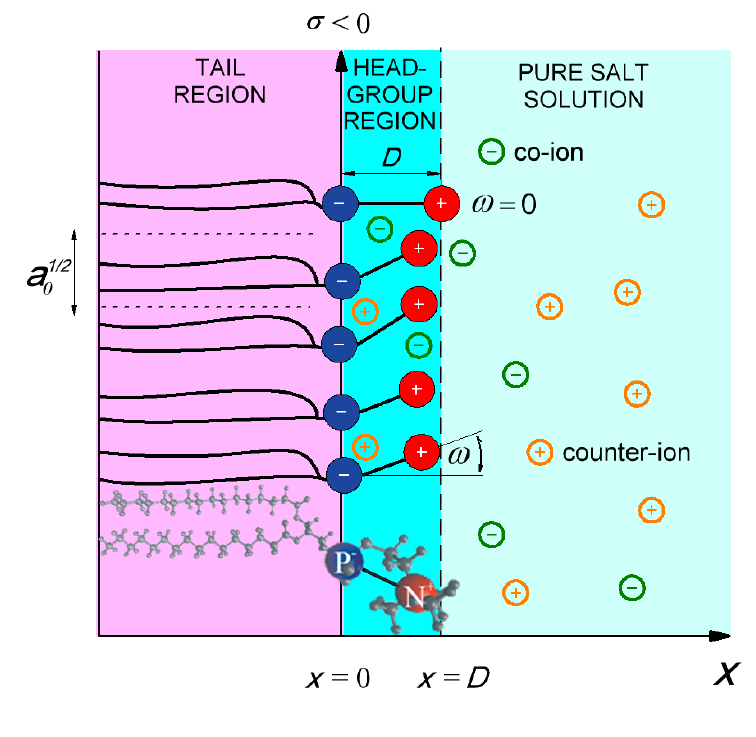
Figure 2. Negative charges of dipolar (zwitterionic) lipid headgroups are described by negative surface charge density σ = − e the distance between charges within the single dipolar lipid headgroup, while ω describes orientation angle of the dipole within the single headgroup. MD model of DPPC lipid molecule is presented at the